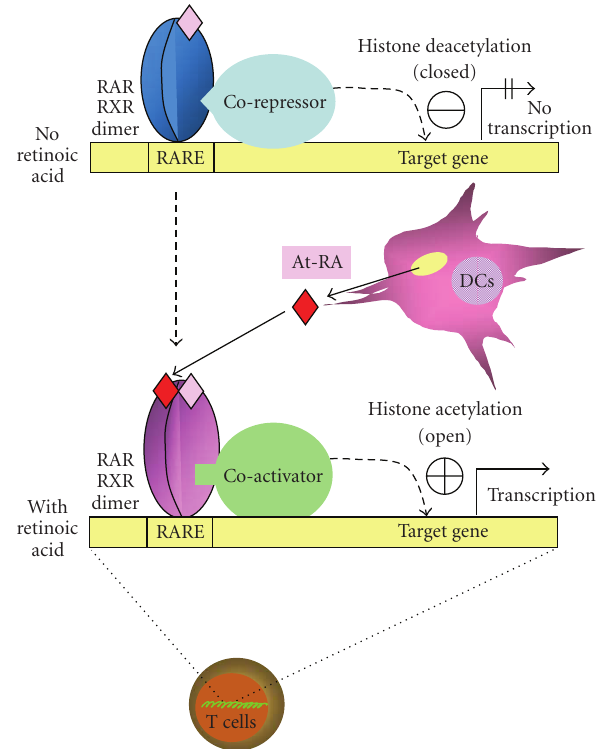
Figure 2: Control of gene expression by retinoic acid . RAR-RXR het- erodimers serve as the nuclear receptors for retinoic acid. When RAR ligands (e.g., At-RA) are not available, the RAR-RXR het- erodimers attract corepressors and histone acetyl deacetylases to the genes which are under the control of retinoic acid response elements (RARE: direct repeats of AGGTCA with a 5-bp spacer; also called DR-5), resulting in a closed conformation of the chromosome and blocked transcription. When RAR ligands are available in a tissue microenvironment (e.g., produced from dendritic cells in the in- testine), they would enter into T cells and activate RAR-RXR het- erodimers. This is followed by the release of corepressors and at- traction of coactivators, which, in turn, recruit histone acetyl trans- ferases, resulting in an open conformation of the chromosome and transcription of the genes. In this regard, the human and mouse FoxP3 promoters have several RARE’s and become acetylated at hi- stones in response to retinoic